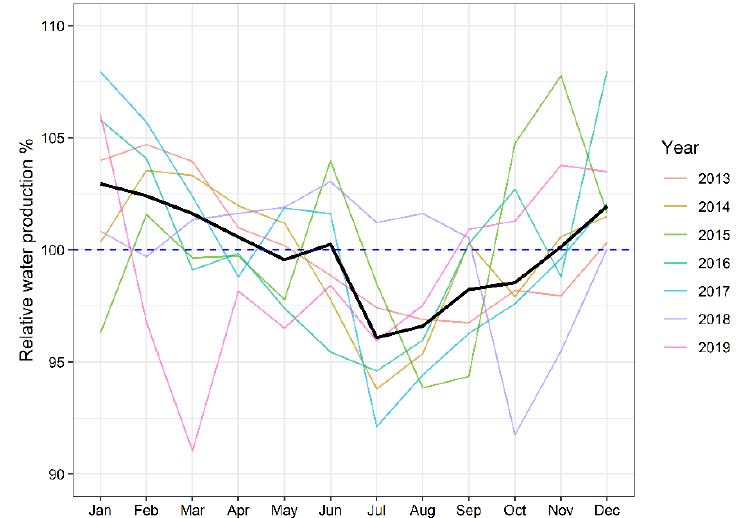
Figure 5. Relative water demand in CILE service areas by month. The blue dashed line corresponds to the average daily demand of that year. The black line is the average relative water production of all years.